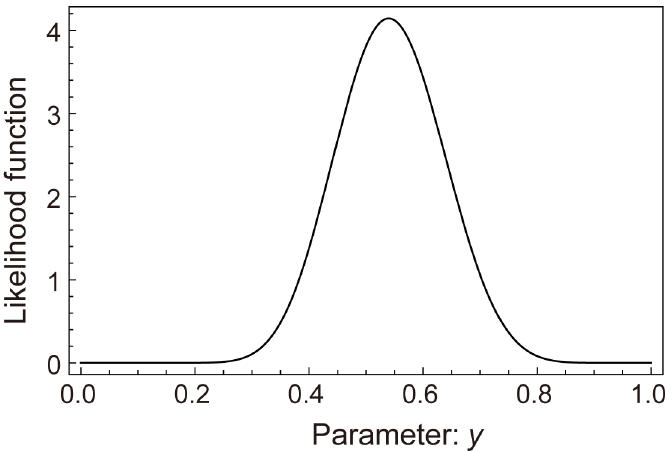
Fig 3. Result of the Bayesian inference. The likelihood function is depicted for the parameter y . The solid curve represents the marginal posterior distribution. We used the uniform distribution as a prior probability. The likelihood function was calculated from the data in Table